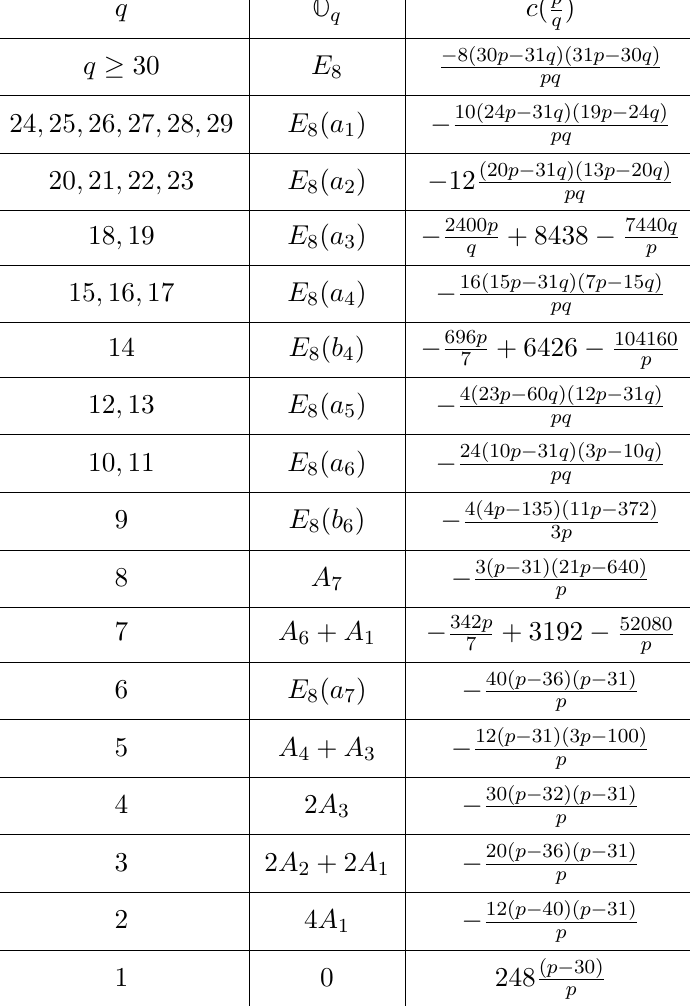
Table 10 . Orbits in E 8 Lie